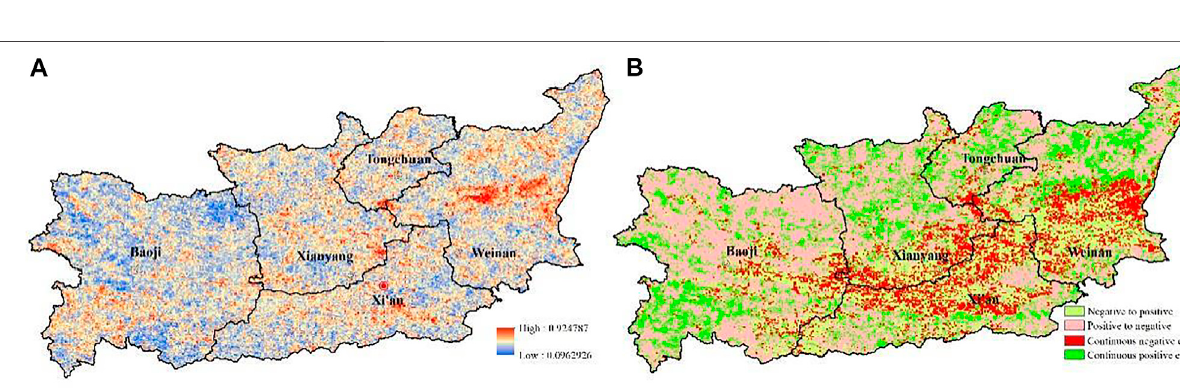
Frontiers in Earth Science |